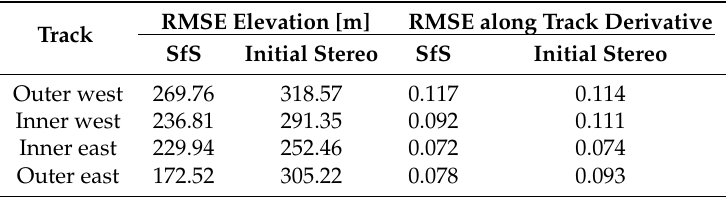
Table 7. RMSE of the elevation (Figure 14) and the first derivative (Figure 15) along the tracks in Figure 13b calculated for the SfS DTM and the initial stereo